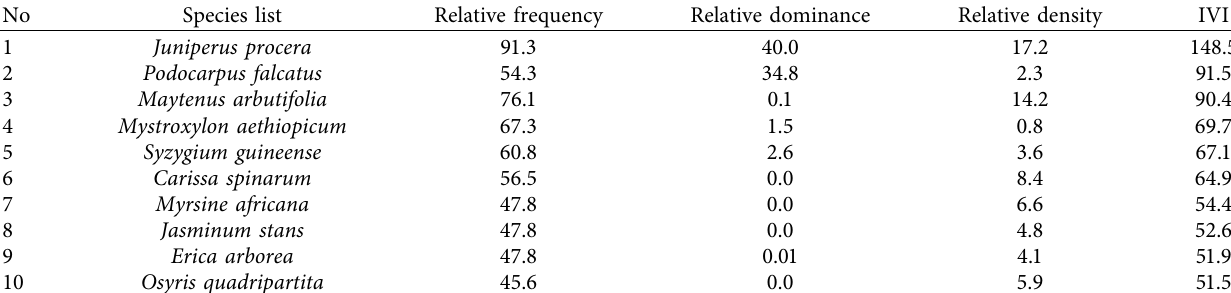
Table 3: Showing the IVI value of the top 10 dominant species in the Gennemar forest.